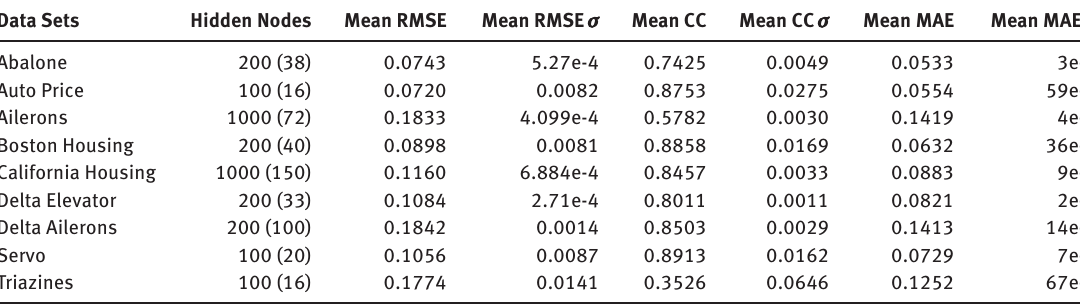
Table 3. Mean Value and Standard Deviation of RMSE, CC, and MAE for the Proposed